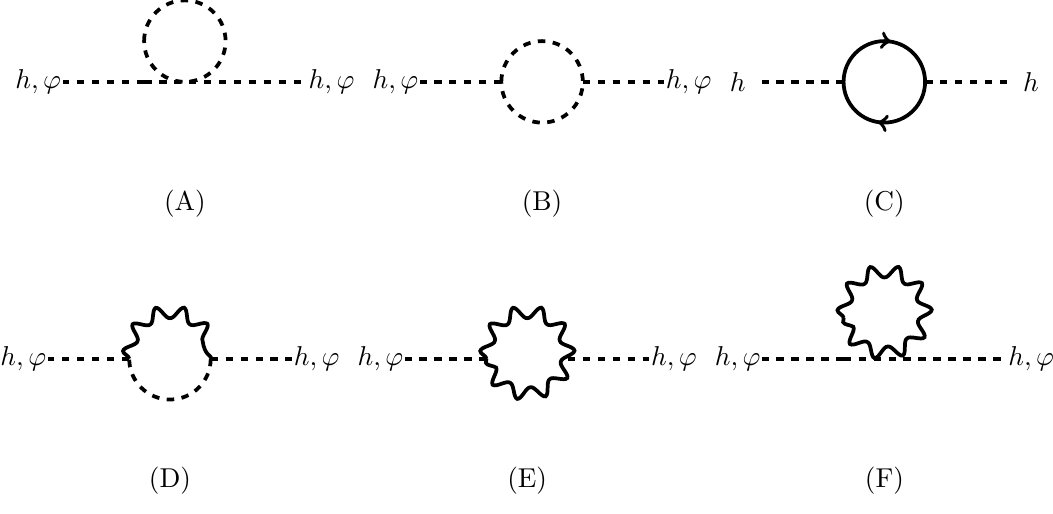
Figure 1 . Diagrams contributing to the scalar self